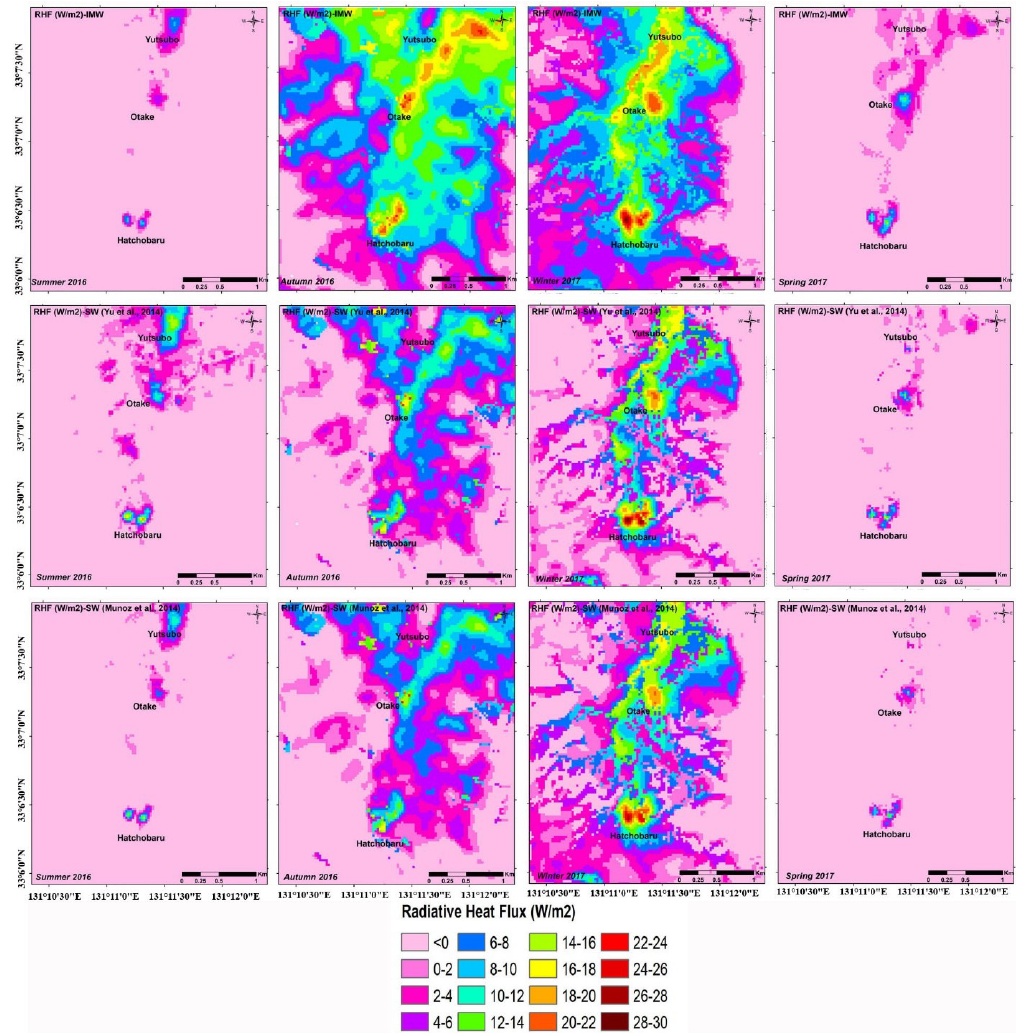
Figure 18. Seasonal radiative heat flux (RHF) in the study area for nighttime Landsat 8 thermal infrared data. The RHFs for each season processed using the improved mono-window (IMW) algorithm are shown in the top row; the RHFs for each season processed using the split-window (SW) algorithm of Yu et al. [19] are shown in the middle row; while the RHFs for each season processed using the SW algorithm of Jiménez-Muñoz et al. [20] are shown in the bottom row. The seasons are arranged in the order of summer, autumn, winter, and spring, in all of the rows.